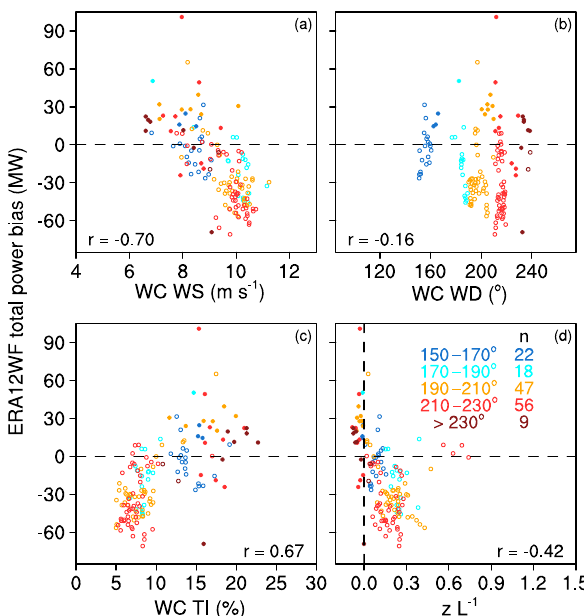
Figure 9. As in Fig. 8, and only including data when the winds are accurately simulated in the ERA12WF run: the modelled–observed absolute error in WS smaller than 1ms − 1 and the absolute error in WD smaller than 5 ◦ . Different colours represent different WD bins: 150–170 ◦ in blue, 170–190 ◦ in cyan, 190–210 ◦ in orange, 210–230 ◦ in red, and 230 ◦ and beyond in maroon. The n values illustrate the sample size in each WD bin. Solid circles represent unstable conditions ( zL − 1 smaller than 0) and hollow circles rep- resent stable conditions ( zL − 1 larger than 0).